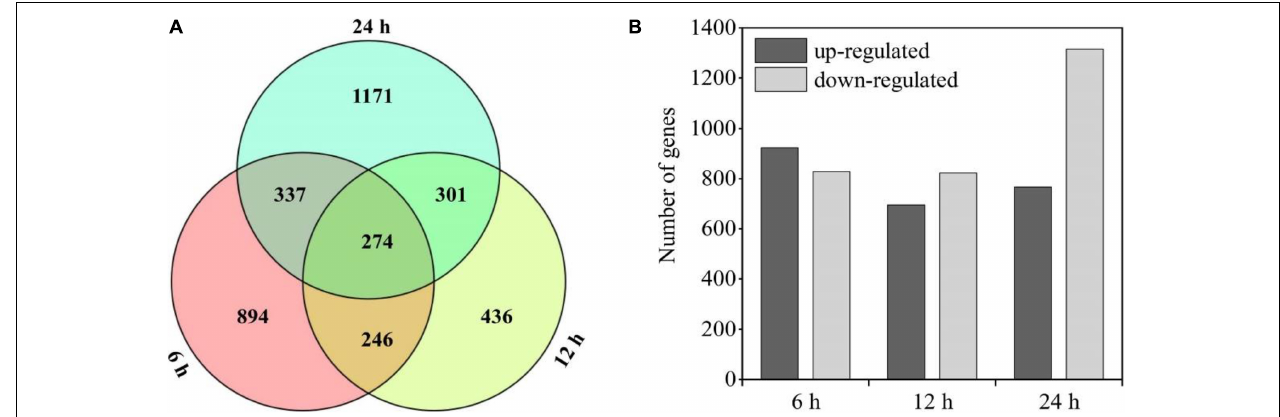
FIGURE 5 | Statistical chart of heterotrophically grown S. acuminatus cells subjected to the high-light and N-limited conditions. Venn diagram representation of shared/unique genes (A) and number of differently expressed genes (DEGs) (B) compared to heterotrophically grown cells at 6, 12, and 24 h of cultivation,